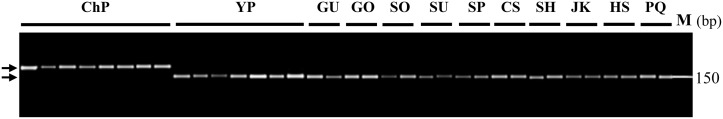
Application of ChP-specific marker, pgcp139f*r2, to individuals of each ginseng cultivar.A total of 72 individuals from 11 P. ginseng cultivars and P. quinquefolius (5~20 individuals for each cultivar) were analyzed using PCR marker pgcp139f*r2 and represented eight individuals for ChP and two to seven for the other cultivars. Amplified DNA fragments were separated by capillary electrophoresis using a Fragment analyzer. Abbreviated cultivar names (defined in Table 1) are given above the lanes. PQ and M indicate P. quinquefolius and DNA size marker, respectively.